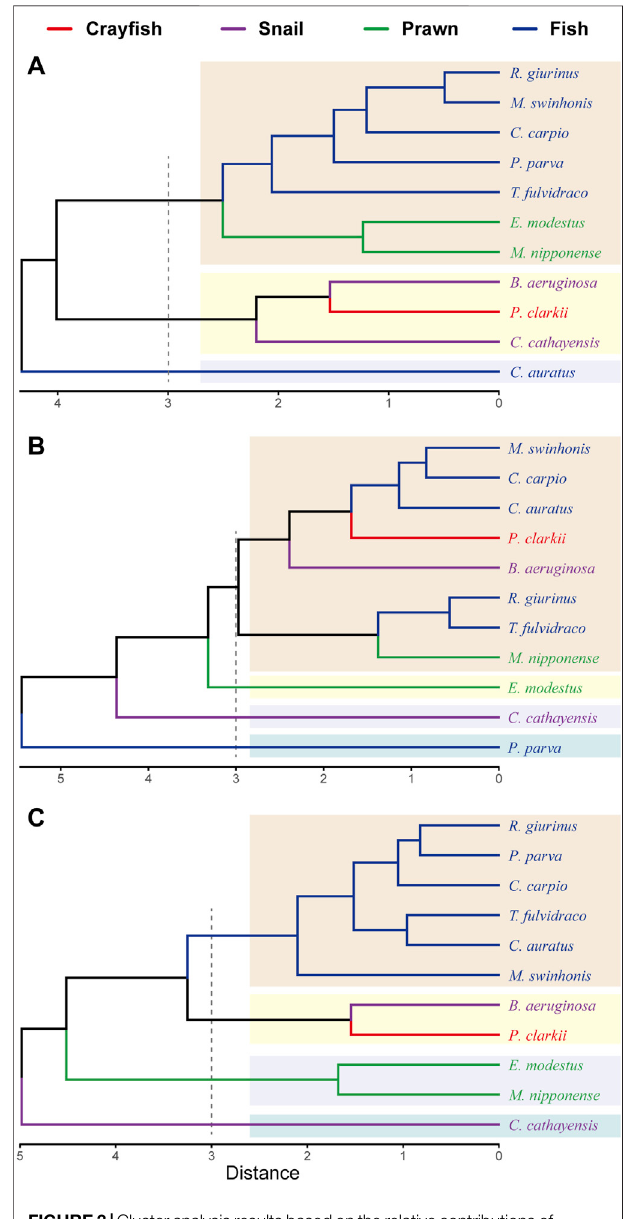
FIGURE3| Clusteranalysisresultsbasedontherelativecontributionsof sources to biomass of red swamp cray fi sh, snails, prawns and fi shes in May (A) , July (B) and October (C) 2019. Delimitation of groups was set at a distance of 3.